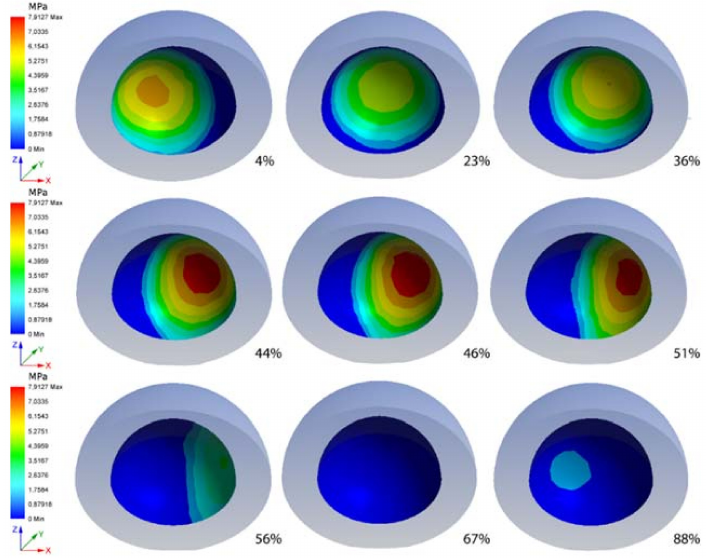
Figure 5. Pressure of the cup in several steps, as expresses in term of gait cycle percentage below each image.